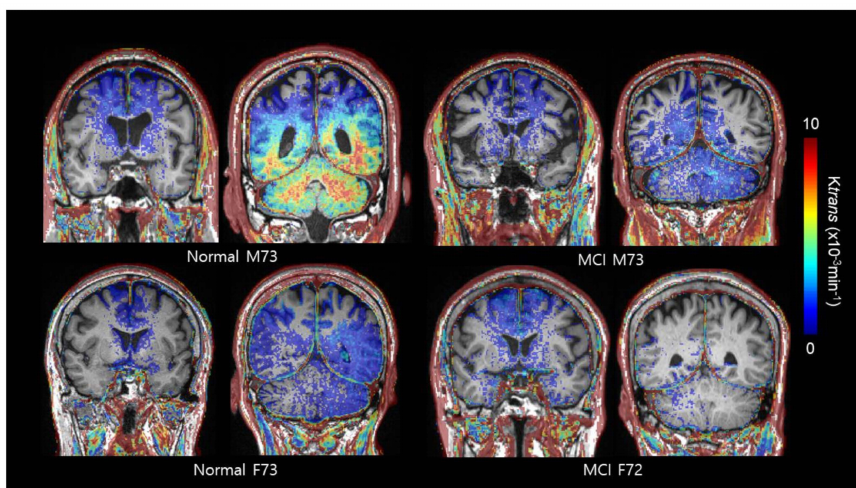
Figure 3. Exemplary cases of BBB permeability imaging (K trans ) by sex and cognitive status. In the normal cognition group, high er BBB permeability in the cingulate and occipital cortex is noted in male subjects compared to female subjects. In contrast, sex differences in K trans were only observed in the occipital cortex in the mild cognitive impairment (MCI)